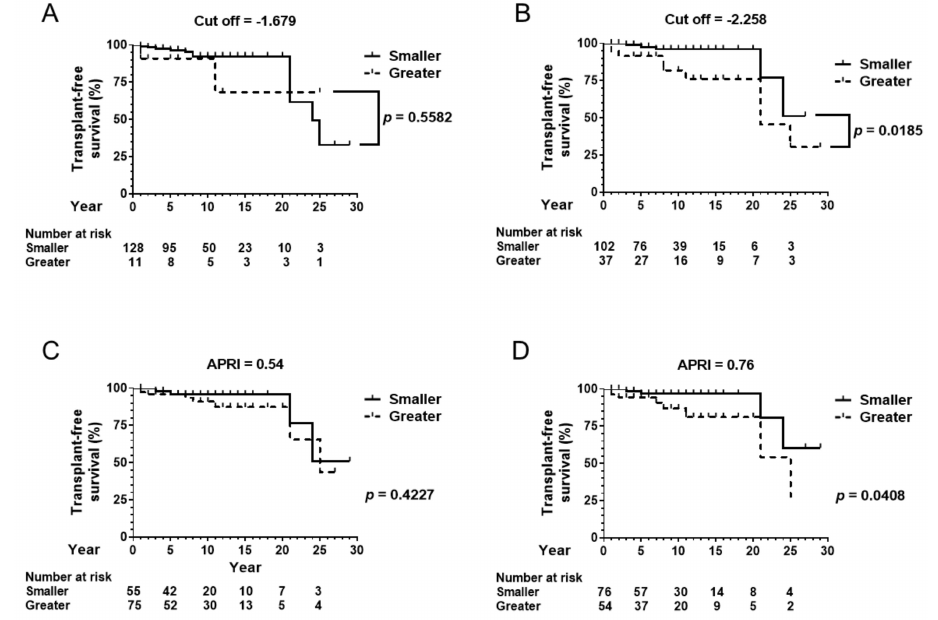
Figure 5. Transplant-free survival in patients under UDCA treatment. ( A ) In 139 patients who were prescribed with UDCA, the cut-o ff value for cirrhosis, an ALBI score of − 1.679, did not di ff erentiate transplant-free survival. ( B ) However, the cut-o ff value of − 2.258, which is a threshold to di ff erentiate advanced fibrosis from nonadvanced fibrosis, stratified transplant-free survival. In 139 patients who were prescribed with UDCA, baseline platelet count was available in 130 patients. ( C ) APRI = 0.54 did not di ff erentiate transplant-free survival. ( D ) APRI = 0.76 significantly stratified the cohort by transplant-free survival. UDCA, ursodeoxycholic